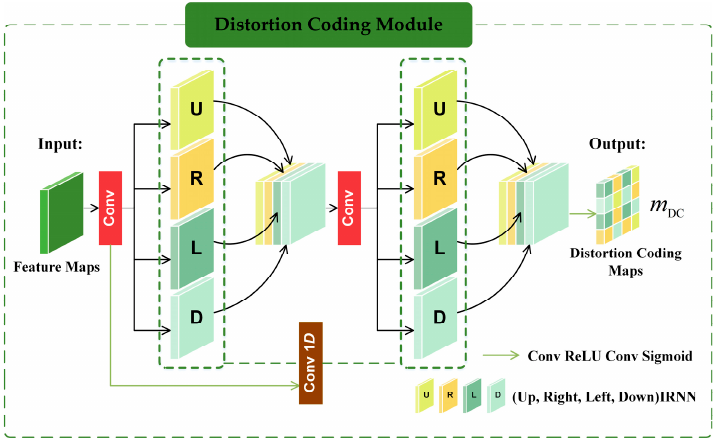
Figure 3. Architecture of the distortion coding module.